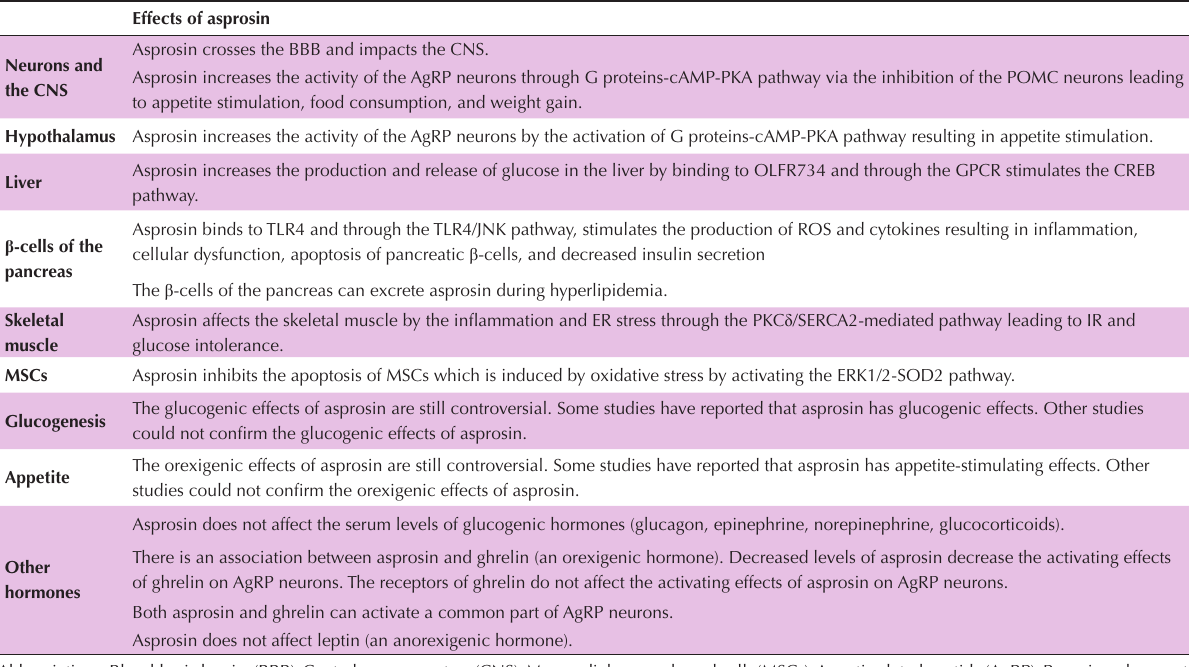
Table 1. The effects of asprosin (1,3,10-14) Effects of